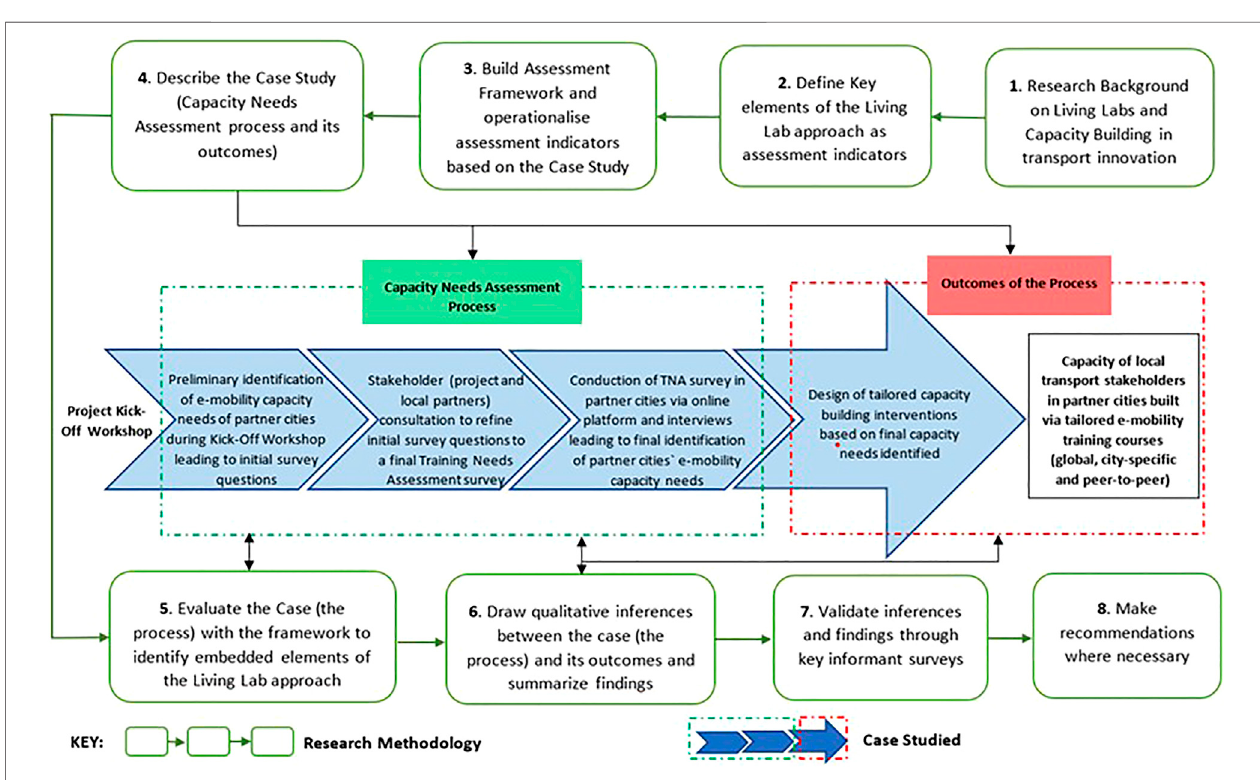
FIGURE 1 | Research